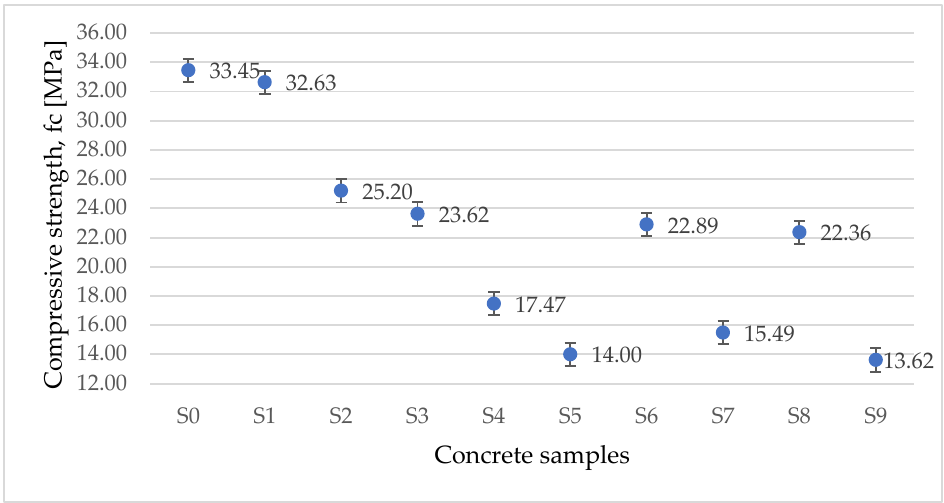
Figure 7. Variation of compressive strength for tested concrete samples .